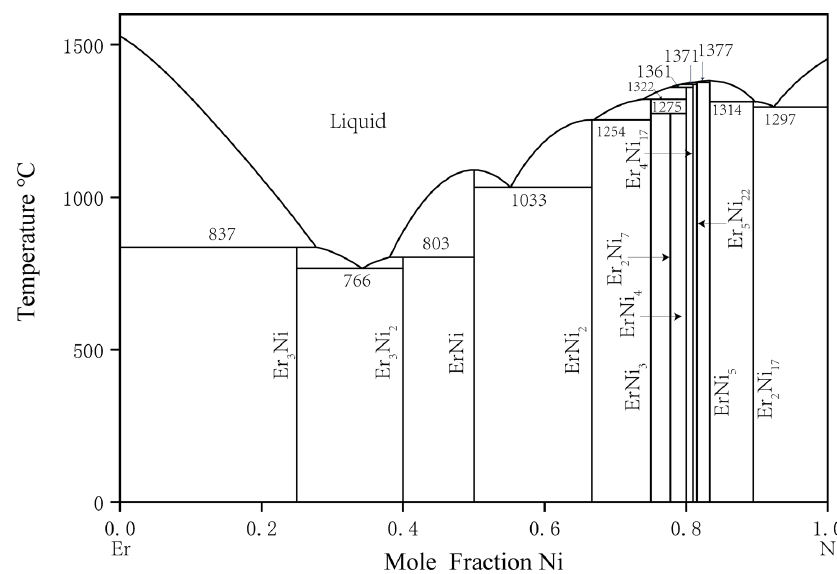
Figure 2. Er–Ni phase diagram assessed by Du et al. [25].